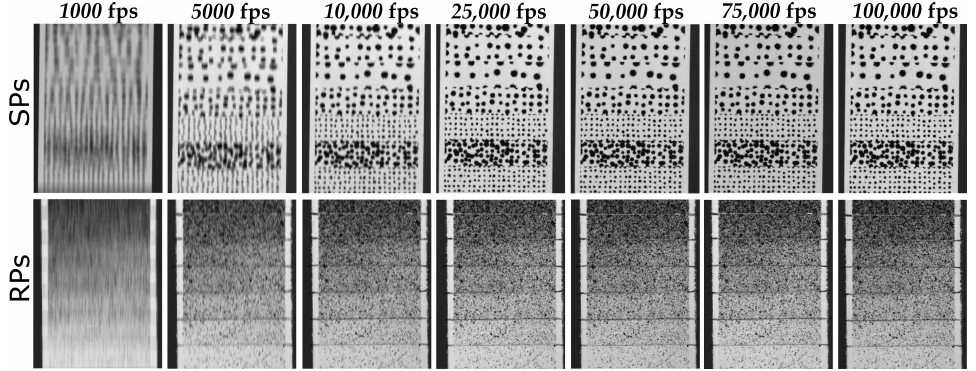
Figure 4. Resulting blurring effect in images recorded at the highest tested velocity with the 7 im- age frequencies.